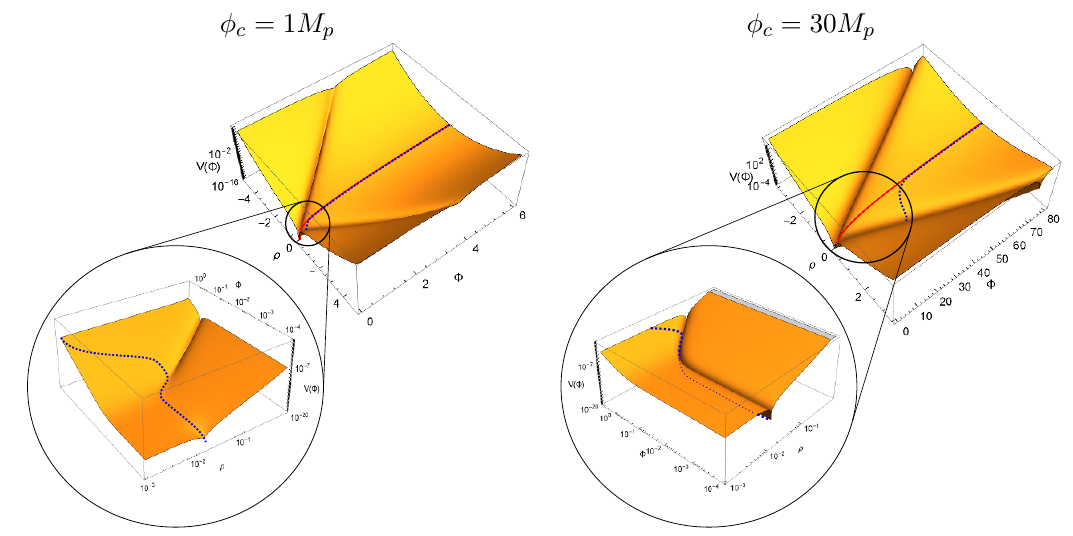
Figure 1 . Schematic representations of the in(cid:13)ationary scenario, in the case where the critical point stands either at small values (left panel) or large values (right panel), corresponding respectively to the cases 1. and 2. enumerated in the text. 0 . 95